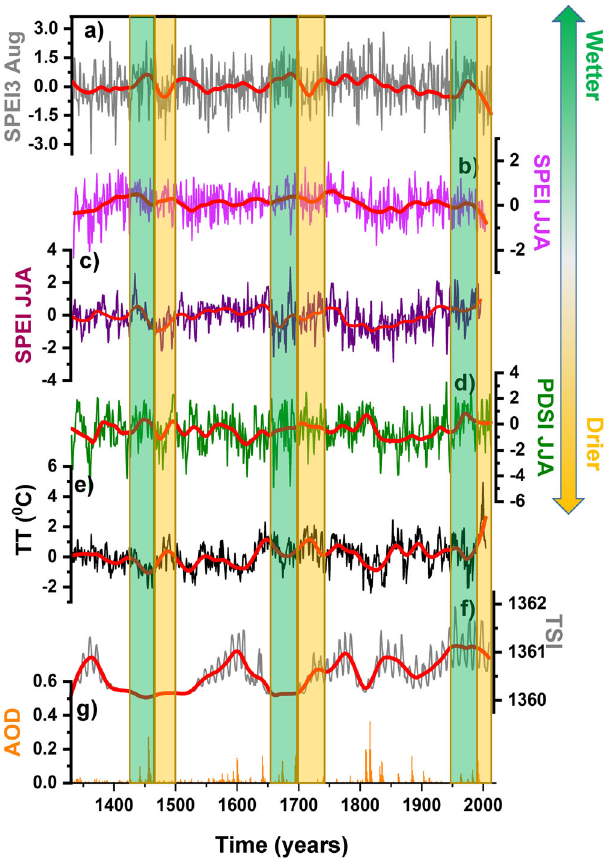
Fig. 7 Comparison among different reconstructions at European